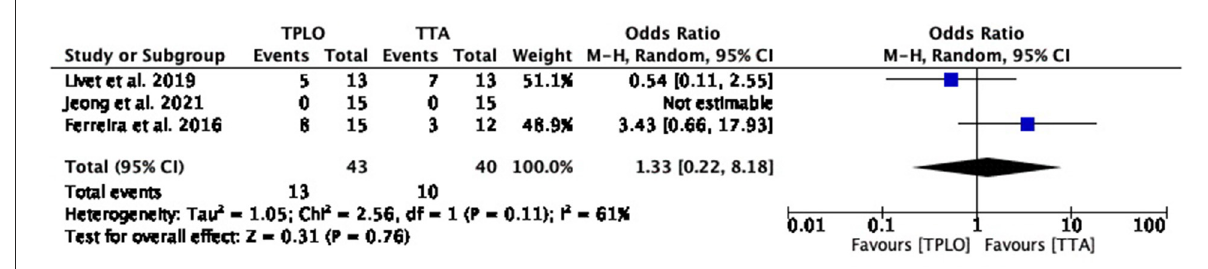
FIGURE2 Forest plot comparing TPLO vs. TTA. Odd ratios (95% CI) of total complications for TPLO and TTA.